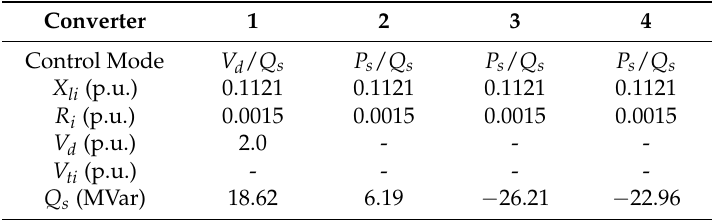
Table 2. Basic parameters, initial controlling modes and setting values of VSCs.